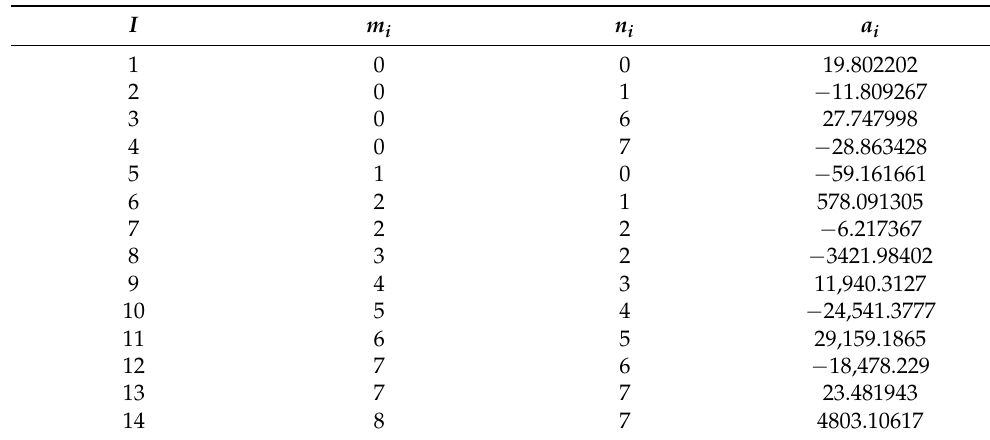
Table A9. Coefficients for Equation (A43)